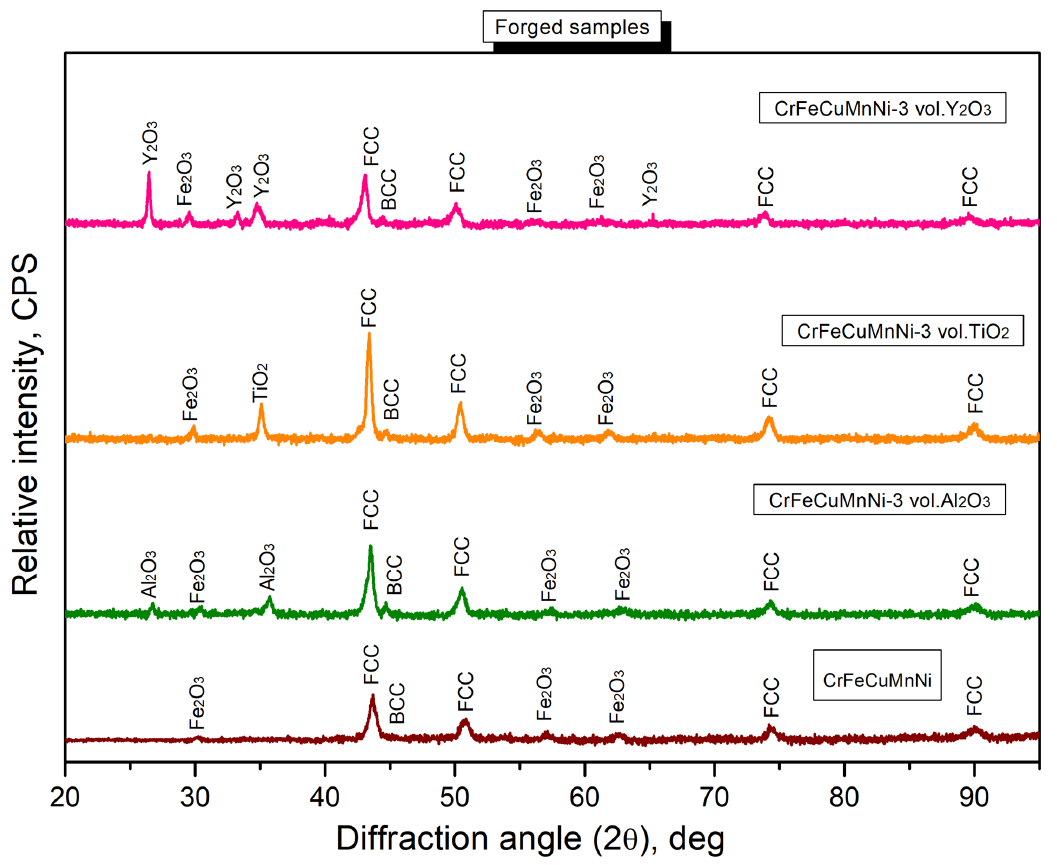
Figure 8 . X-ray diffraction peak profile of forged oxide-dispersed strengthened high-entropy com- posites (ODS-HECs) of CrFeCuMnNi, CrFeCuMnNi-3 vol.% Al 2 O 3 , CrFeCuMnNi-3 vol.% TiO 2 , and CrFeCuMnNi-3 vol.% Y 2 O 3 .